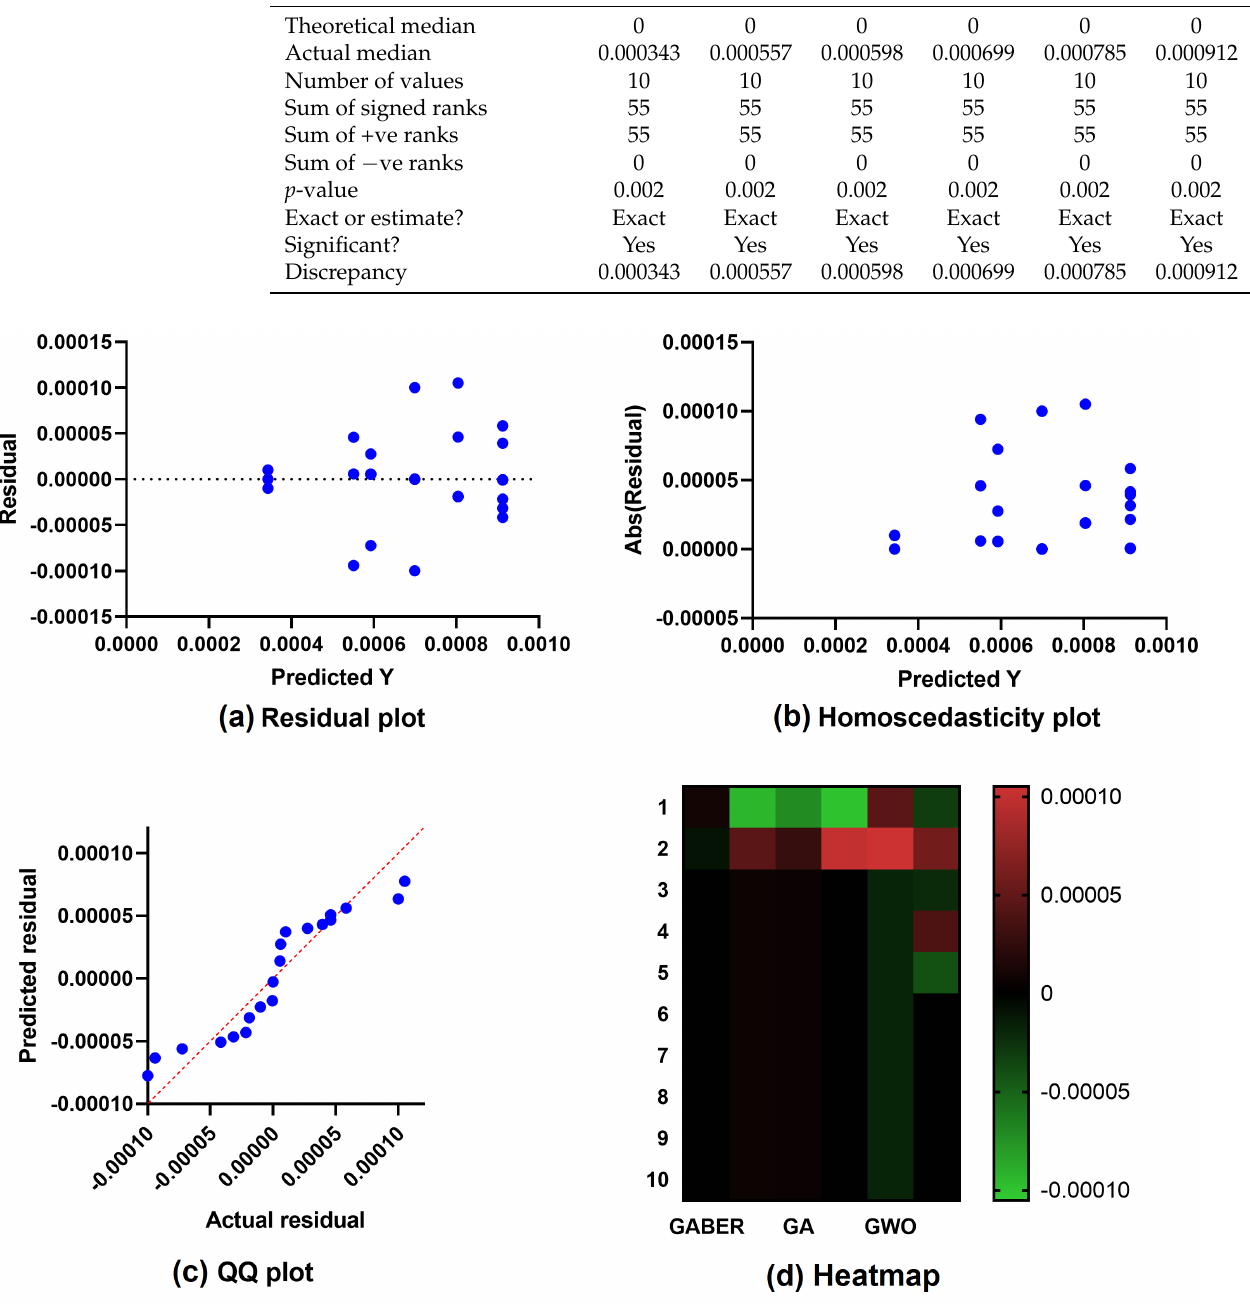
Figure 10. Visualizing the performance of the proposed optimized stacked ensemble in predicting wind